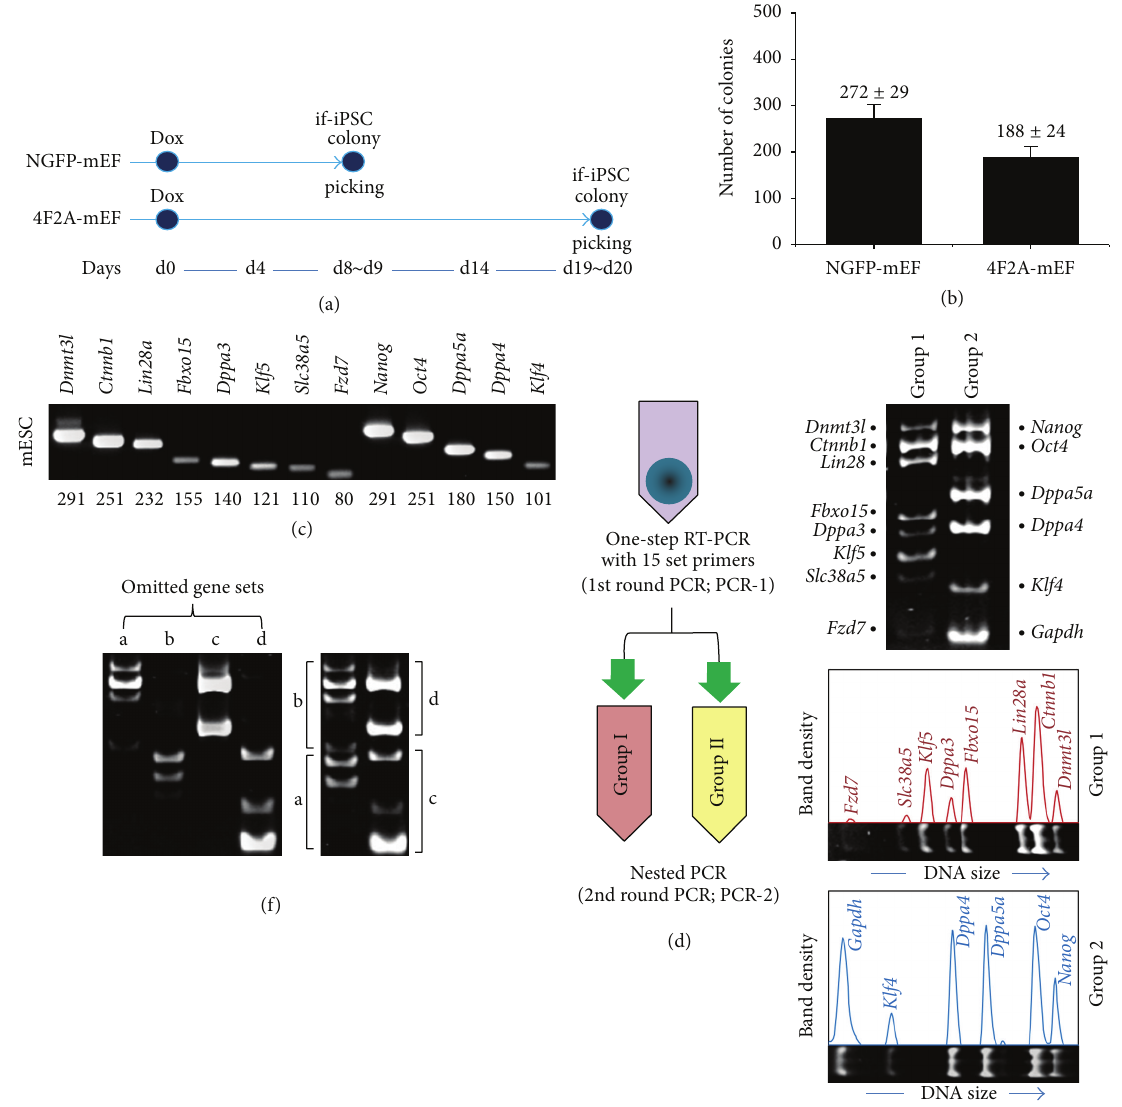
Figure 1: Multiplex reverse transcription-polymerase chain reaction for pluripotency genes in NGFP and 4F2A cells. (a) A schedule for doxycycline (Dox) induction in NGFP-mEF and 4F2A-mEF culture. Initially formed-iPSC (if-iPSC) colonies of proper sizes were picked at indicated times. Dox treatment was maintained until colony picking. (b) The number of pre-iPSC colonies emerged from NGFP-mEF (272 ± 29 per 2 × 10 4 cells) and 4F2A-mEF (188 ± 24). Mean ± standard deviation. 𝑛 = 12 . (c) RT-PCR of individual genes using cDNA from mouse J1 mESCs. The size of PCR amplicon is indicated below. (d) Multiplex RT-PCR strategy. One-step RT-PCR was used as the first round of PCR (PCR-1) and the products advanced to the second-round, nested PCR (PCR-2). (e) A representative gel image (upper) and the corresponding band-intensity profiles of the groups 1 and 2 genes (lower). (f) Control experiments for multiplex RT-PCR using total RNA from J1 mESCs. Omitting each set of primers indicated (a–d) in the PCR-1 cocktail does not greatly change the overall pattern and quantity of the PCR-2 products of the remaining genes in each group, indicating no severe interference between the multiple sets of primers during multiplex